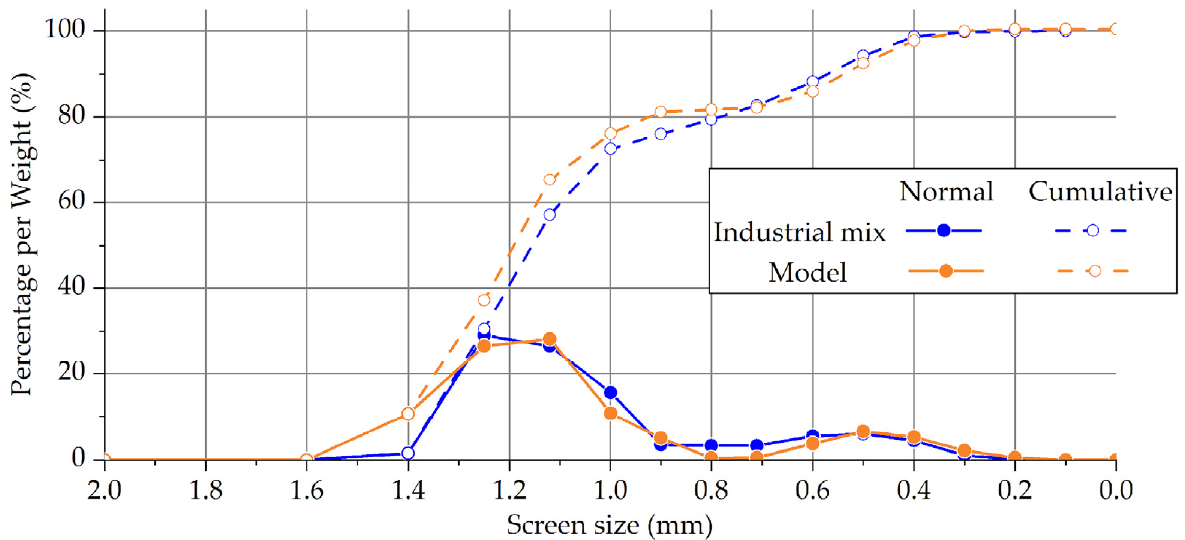
Figure 5. Comparison between sieve analysis and generated shots for the 2D FEA model; shot percentage per weight.